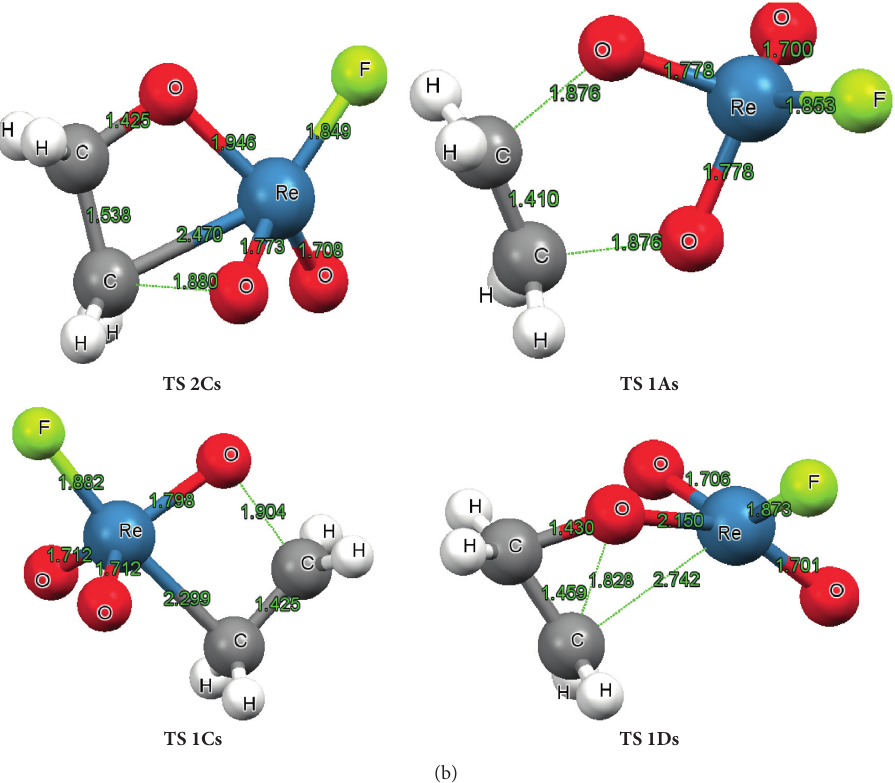
Figure 1: (a) Gibbs free-energy profile diagram for the reaction between ReO Optimized transition states involved in the reaction between ReO 3 F and ethylene at the B3LYP/LACVP ∗ level of